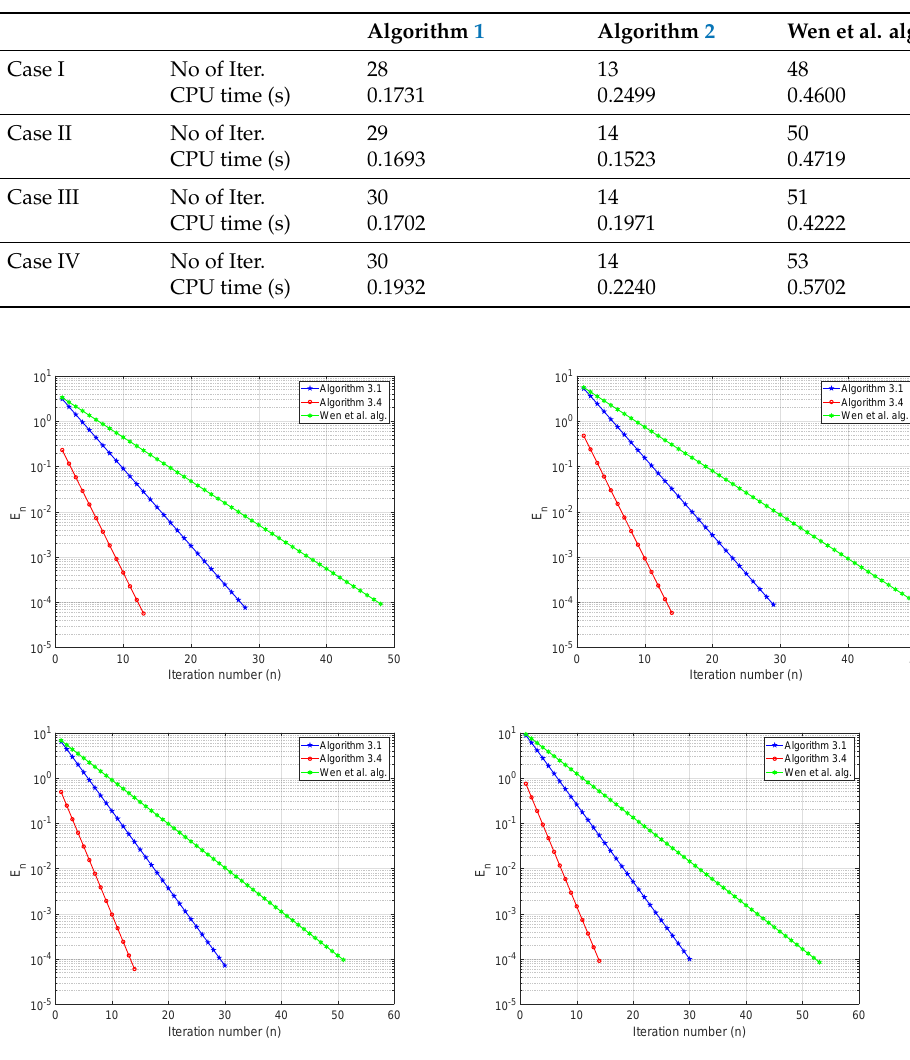
Table 1. Computation result for Example 1.